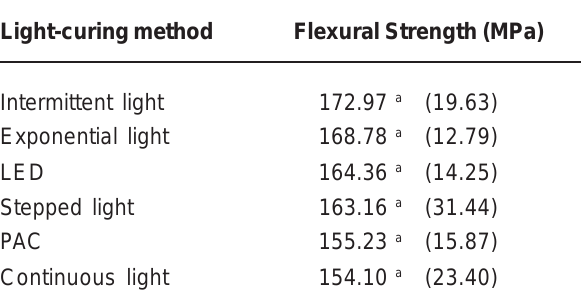
TABLE 4- Means of flexural strength of Z250 composite resin